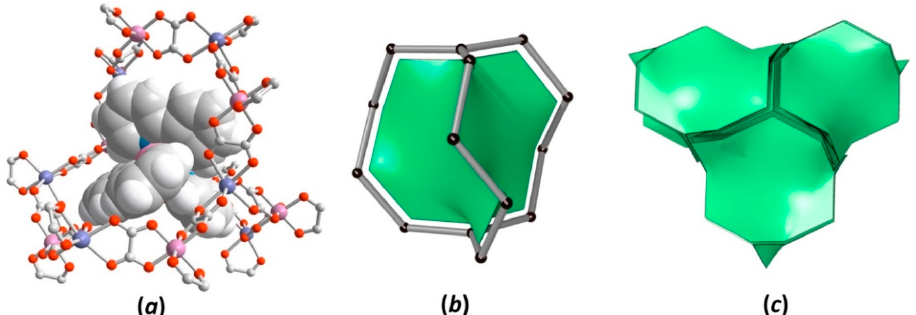
Figure 3. ( a ) Perspective view of the [Z II (bpy) 3 ] 2+ (Z II = Zn 2+ , Cu 2+ , Ru 2+ , Os 2+ ) complex hosted in the anionic three-fold cage. ( b ) Simplified topological representation of the anionic cage (black nodes are Ru III and M I metal centers; grey rods are the oxalate ligand) with the srs triangular tile. ( c ) Tile packing, which reconstructs the cage structure in the 3D honeycomb-like framework.